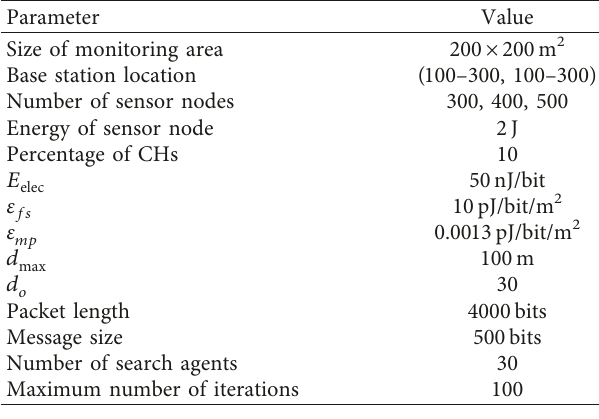
Table 2: S imulation parameter.